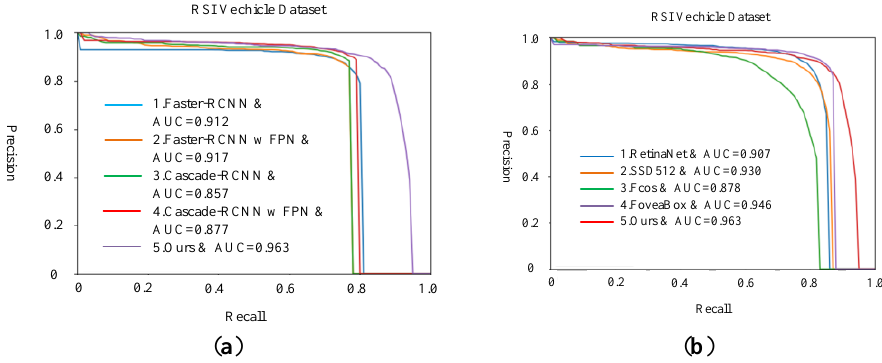
Figure 13. PR curve of the RSI experiment: ( a ) two-stage, ( b ) single-stage. Figure 14a–g show the detection results for different anchor-based models on the RSI data set. The green box is the detection result, and the red box is the undetected vehicle.